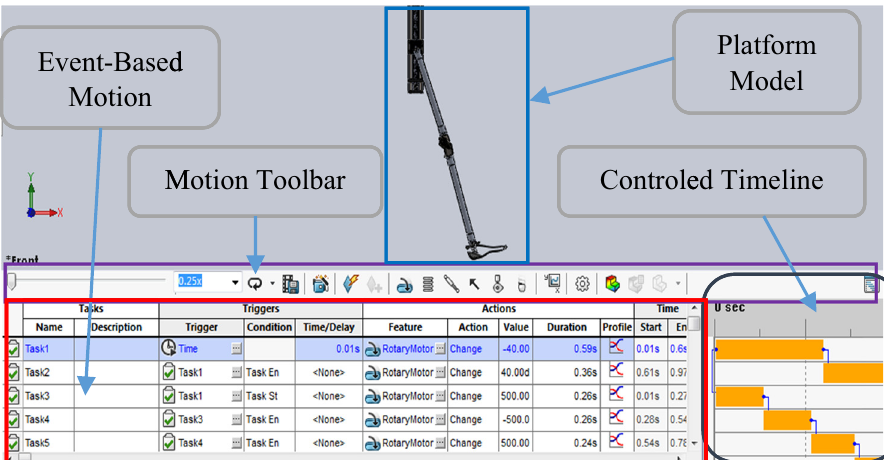
Figure 9: User interface of SolidWorks motion.